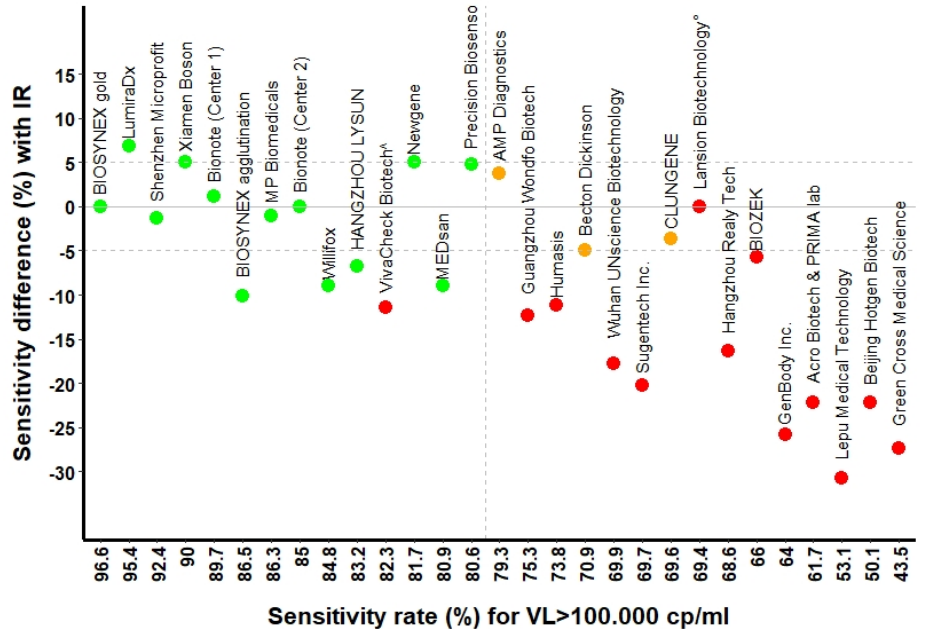
Figure 2. RATs sensitivity rates for viral loads above 105 copies/mL compared to the internal reference test. Figure 2 legend. Green and red dots represent the assays passing and not passing FOPH validation criteria, respectively; orange dots represent the assays validated using the non-inferiority criteria to the internal reference. The solid line represents the internal reference (Standard Q ® , SD Biosensor/Roche). Dashed horizontal lines represent the limits of difference in percentage within which sensitivity rates’ variations were considered acceptable compared to the IR. The vertical dashed line coincides with 80% cut-off, which was considered the minimal sensitivity threshold for FOPH validation above 105 copies/mL of viral load. ^: this test did not pass the validation criteria for insufficient sensitivity at viral loads above 106-107 copies/mL. °: this test did not pass the validation because of lack of specificity.